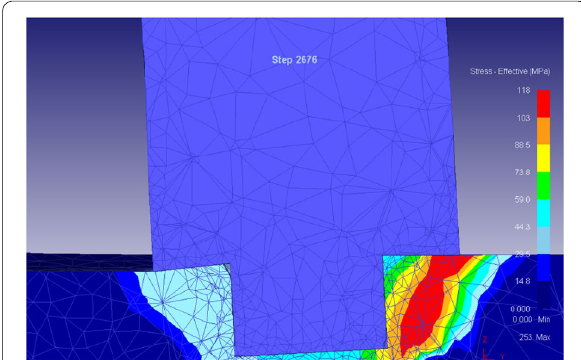
Figure 18 Stress distribution during the transverse speed of 20 mm/s and rotational speed of 1000 min − 1 [114]